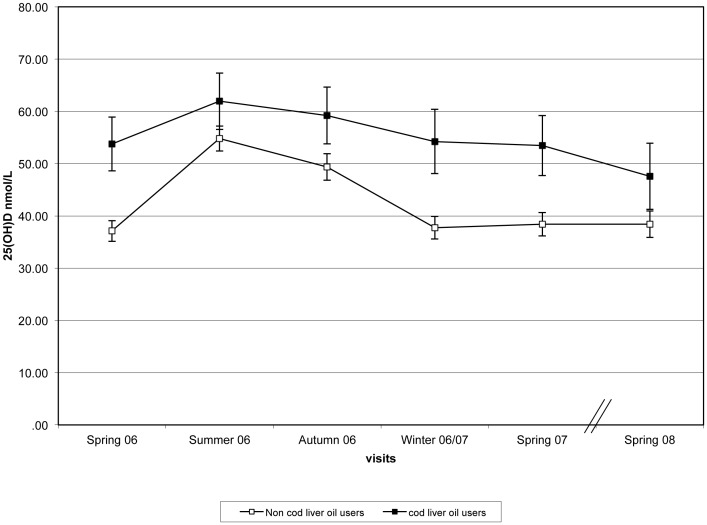
Differences in 25(OH)D between women that reported taking cod liver oil supplements [N = 50 (spring 2006), 47 (summer 2006), 46 (winter 2006/07), 44 (spring 2007), 37 (spring 2008] vs. those who did not (n = 303, 289, 285, 269, 268, 221, respectively).(all differences where statistically significant at p<0.003 except for Summer for which p<0.01.) 25-hydroxyvitamin D (25(OH)D) (bars represent mean ± SEM) according to season/visit.